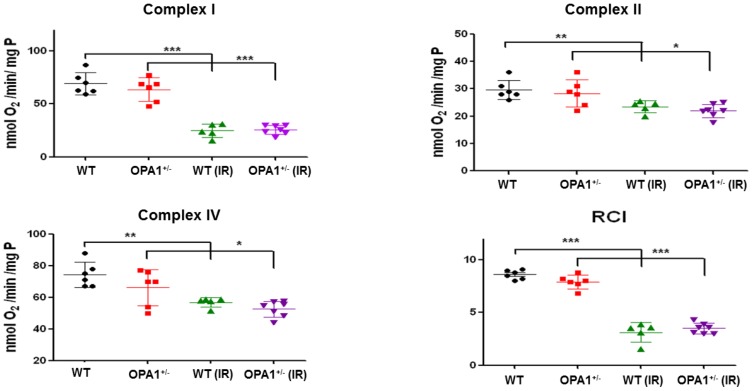
Baseline and post-I/R oxidative phosphorylation.Complex I, II, and IV oxygen consumption were measured in WT and Opa1+/- mouse hearts at baseline and after I/R (n = 6/group). The I/R protocol consisted of 45 minutes of ischemia and 2 hours of reperfusion. The ratio [state 3 rate]: [state 4 rate] is represented by means of the respiratory control index (RCI) in both groups at baseline and after I/R. Values are mean ± SEM. *p<0.05, **p<0.01, ***p<0.001.